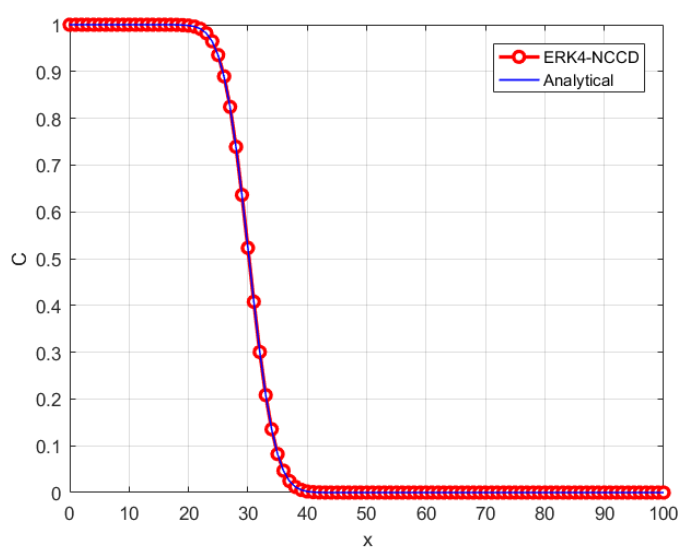
Figure 1. Analytical and numerical solution of the ADE with constant parameters for ∆𝑡 = 1 s.